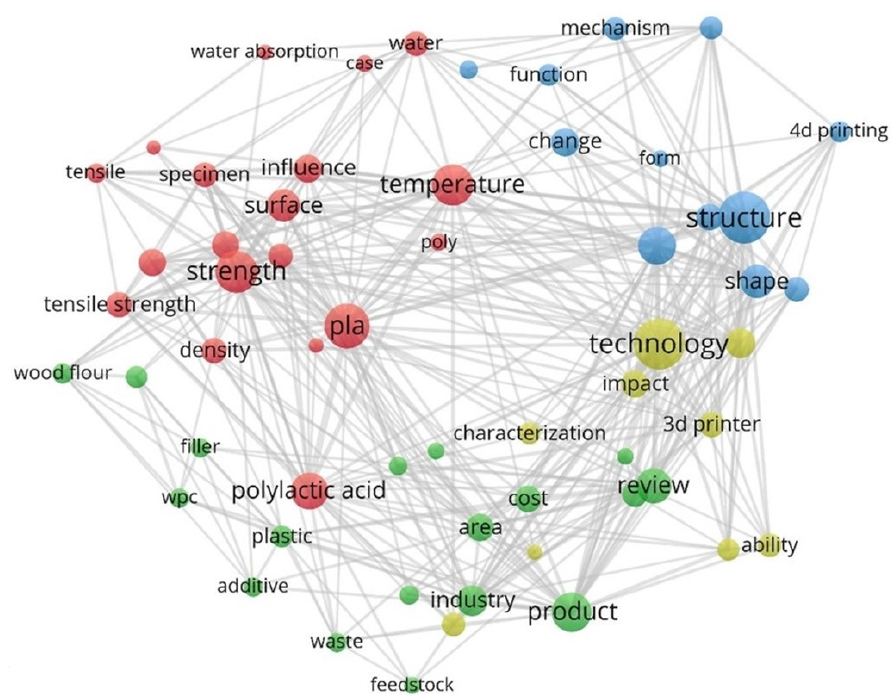
Figure 1. The terms that appeared most in our Mendeley reference database-terms visualization network from VOSviewer v1.6.18 software.